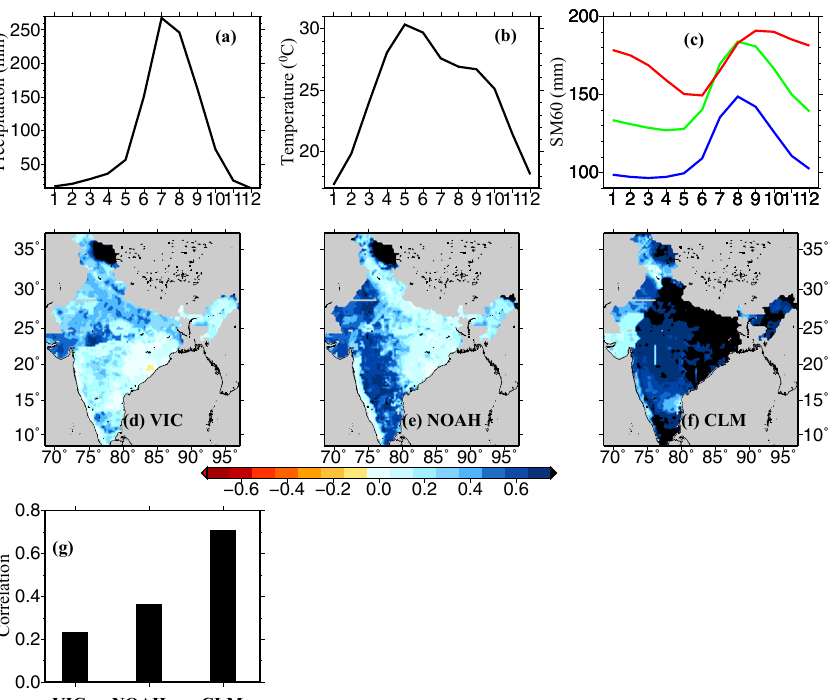
Figure 3. Uncertainty in persistence in root-zone soil moisture (60cm). Seasonal cycle of all-India averaged (a) precipitation, (b) mean air temperature, and (c) 60cm soil moisture simulated using the VIC (blue), the Noah (green), and the CLM (red). (d–f) Autocorrelation in 60cm soil moisture at a 4-month lag simulated using the VIC, Noah, and CLM, respectively. (g) All-India median autocorrelation (4-month lag) in the 60cm soil moisture from the three